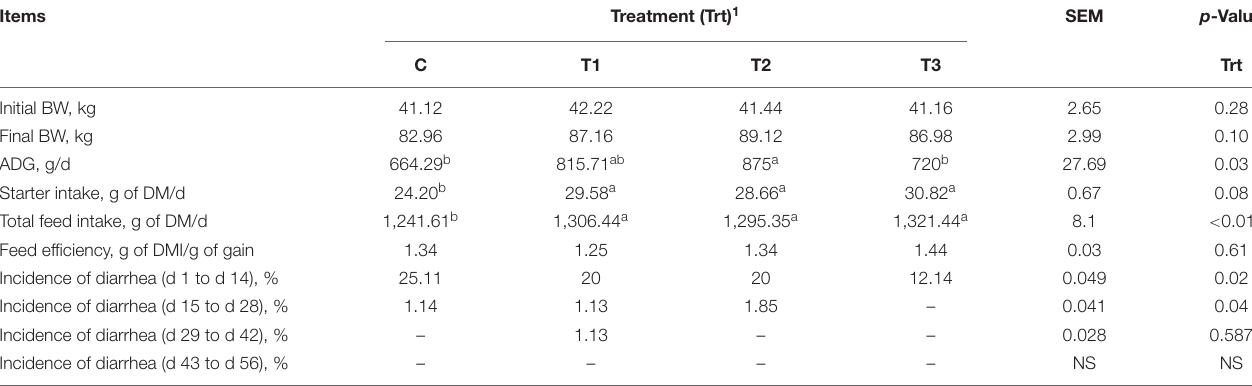
TABLE 2 | The growth performance and incidence of diarrhea in Holstein dairy calves fed with different doses of multispecies probiotics. Items